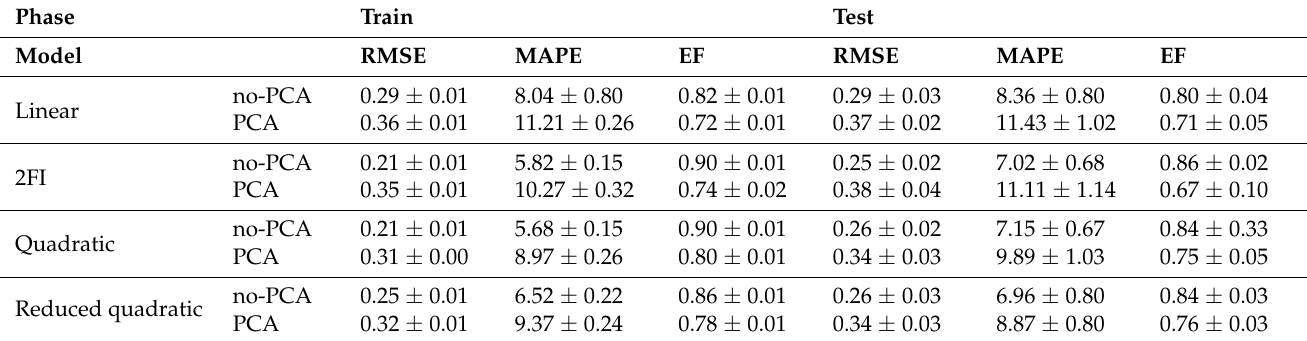
Table 4. Comparison of the yield predictions of four MLR model types before and after PCA